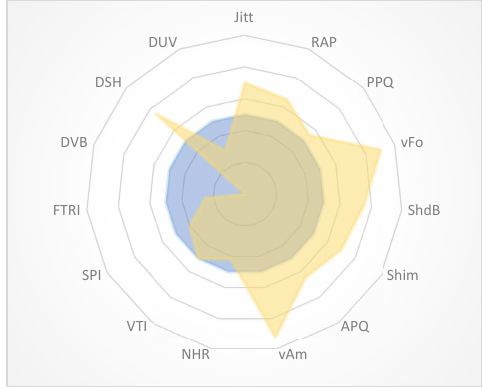
Figure 9. Example of an MDVP graph, adapted from [30].